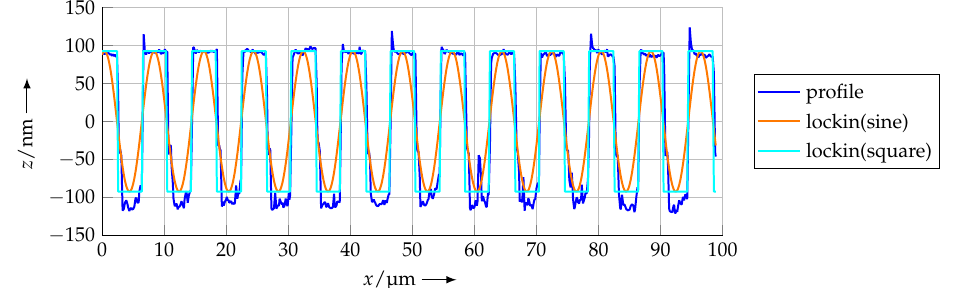
Figure 14. Approximated sine function and square function, tuned to the measured profile by a lock-in